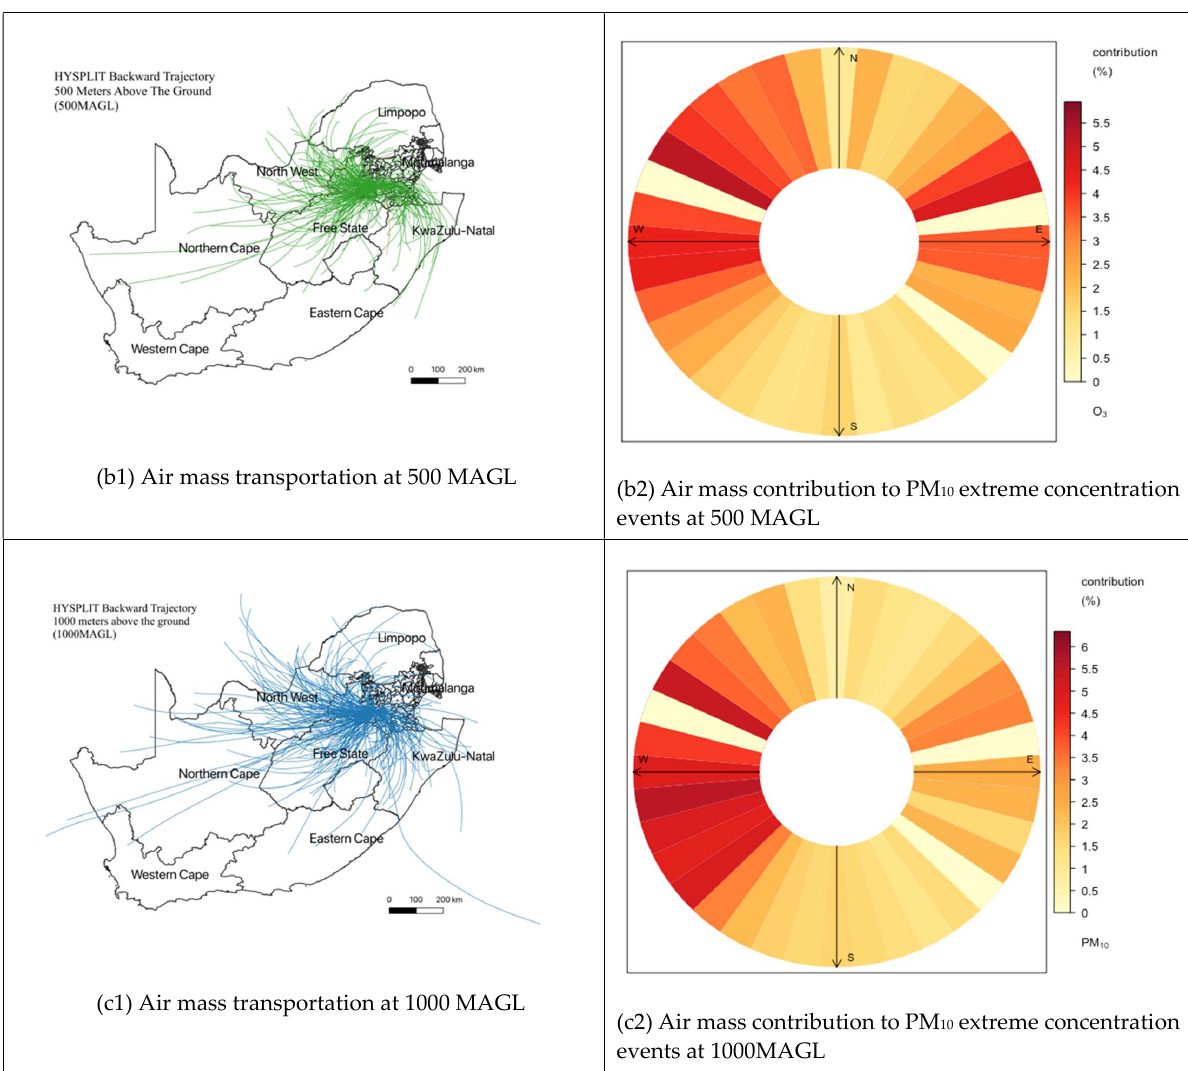
Figure 11. Long-range transportation of air masses during extreme concentration events of C3 and C4 within 10MAGL, 500MAGL, and 1000MAGL, and the contribution of transportation to extreme concentration events.